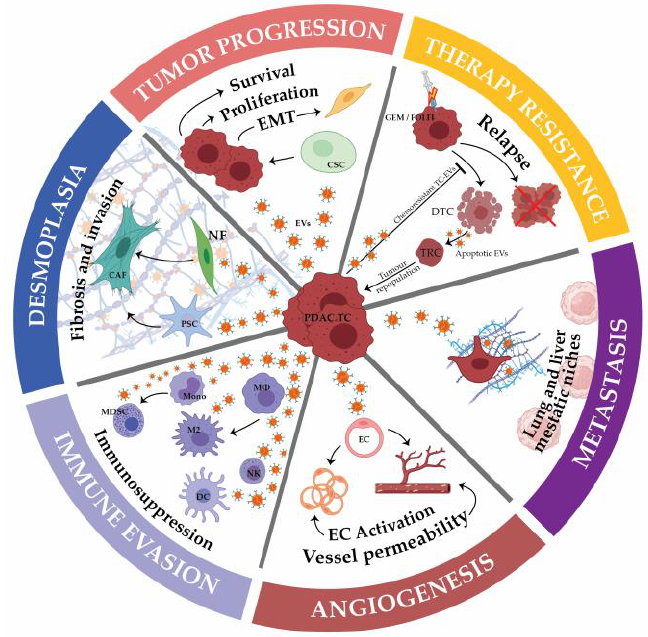
Figure 1. Schematic representation of tumor–stromal cell intercellular communication via EVs and its subsequent outcomes on major cancer hallmarks in PDAC. Cell types: TCs—tumor cells, NFs—normal fibroblasts, PSCs—pancreatic stellate cells, CAFs—cancer-associated fibroblasts, CSCs— cancer stem cells, DTCs—dying tumor cells, TRCs—tumor repopulating cells, GEM—gemcitabine, FOLFI—folfirinox, ECs—endothelial cells, Mφ—macrophages, M2—M2 macrophages, Mono— monocyte, MDSC—myeloid-derived suppressor cells, DCs—dendritic cells, NK—natural killer cells.